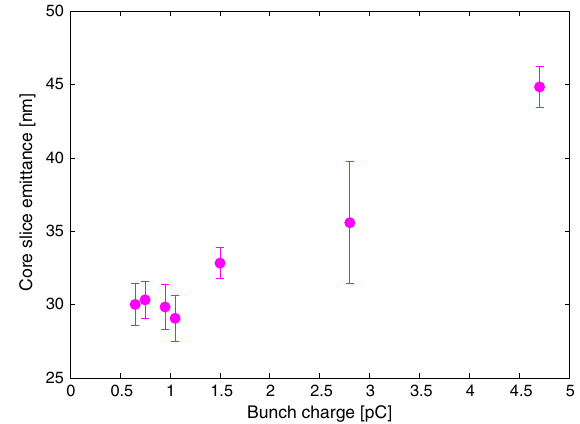
FIG. 1. Example of space-charge limit determination. The field at the cathode was at its nominal value ( 49 . 9 MV = m) and the laser beam size was around 60 μ m. For bunch charges equal or below 1.0 pC the slice emittance is not affected by space charge.